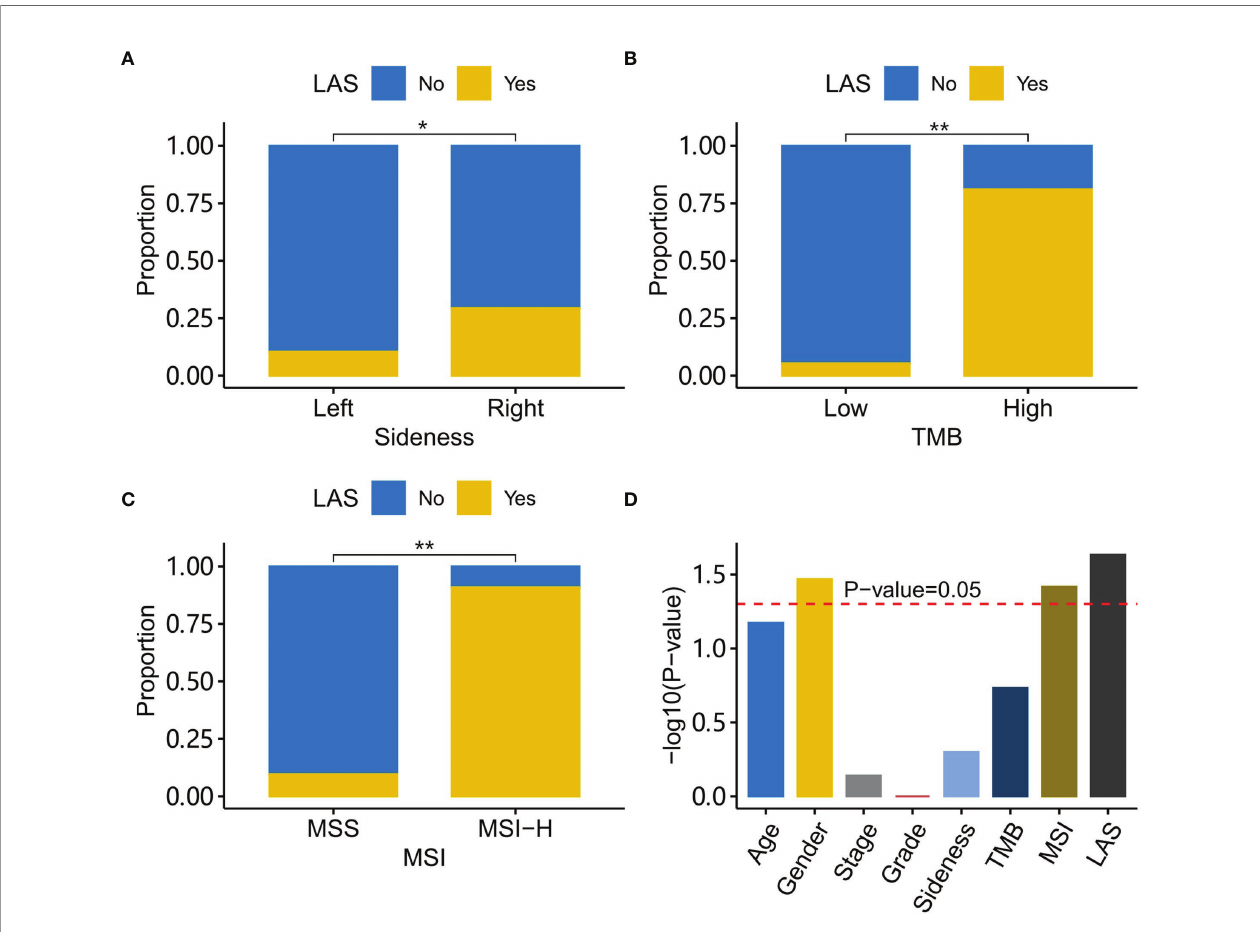
FIGURE 4 | Characteristics of LAS subtype patients. (A) LAS subtype patients have a higher percentage of right-side tumors than the left-side tumor. (B) LAS subtype patients have a higher percentage of high TMB tumors than low TMB tumors. (C) LAS subtype patients have a higher percentage of MSI-H tumors than MSS tumors. (D) Association with a family history of cancer for each clinical character is plotted. The red dash line indicates the association score at P -value=0.05. “ * ” and “ ** ” denote P -value < 0.05 and P -value < 0.001,